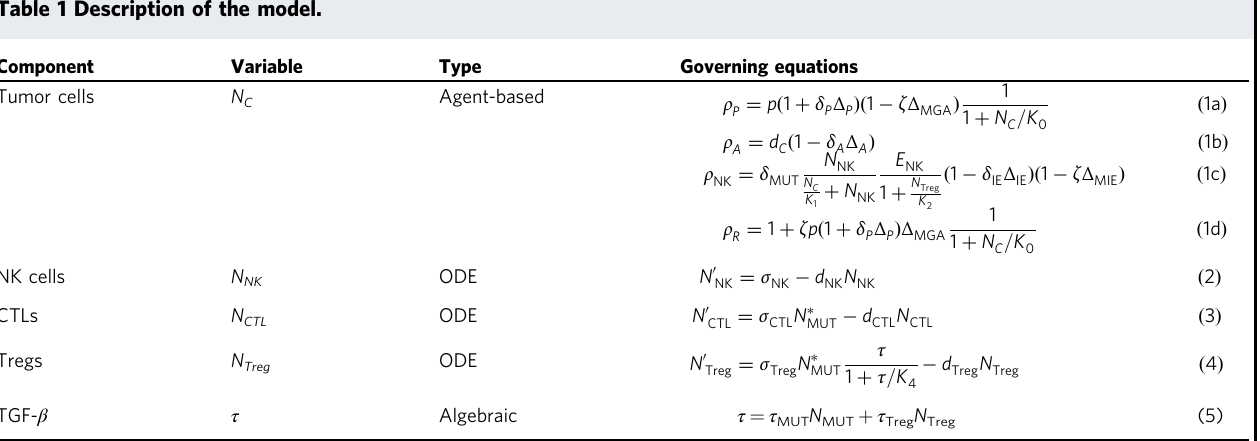
(Fig. 1A), beginning a progression towards invasiveness. EMT affects tumor growth dynamics: we model tumor cells as in one of two states: epithelial tumor cells (ETCs) and MTCs and permit transitions between these states (we leave the addition of intermediate EMT states as future work 83,84 ). Tumor cells — along with their individual mutational pro fi les and EMT status — are the central variables in the model. In addition, three types of immune cells — NK cells, CTLs, and Tregs — are included as continuous variables. In response to the recognition of neoantigens,